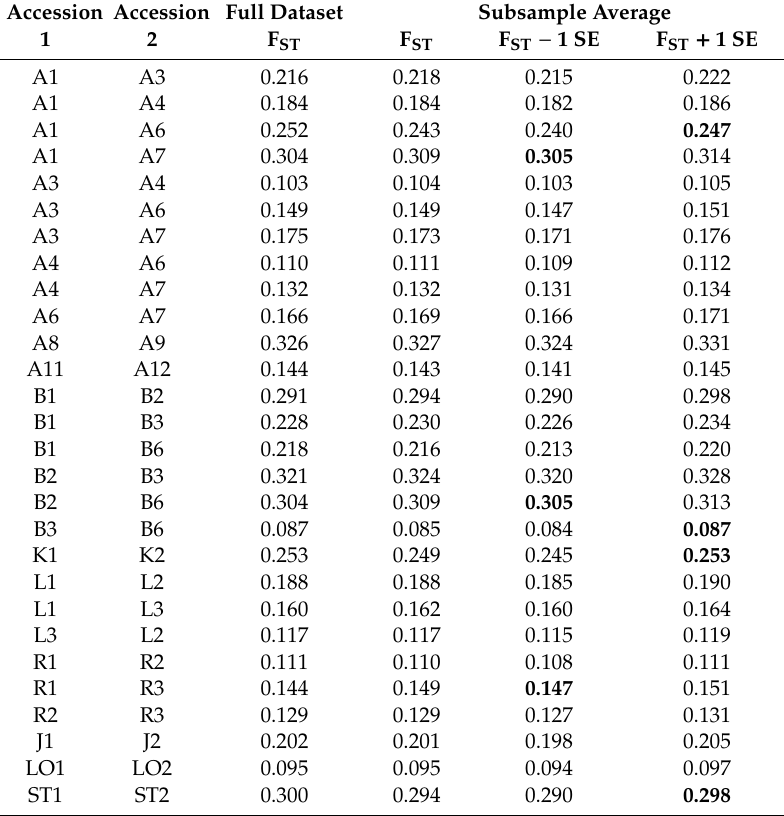
Table 3. Pairwise F ST values within groups based on all markers (full dataset) and from subsets of 10 markers (subsample average). Subsample values that do not include the pairwise F ST value for the full dataset are highlighted in